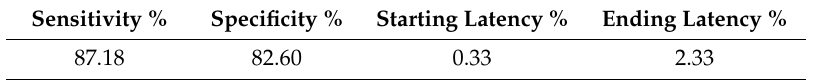
Table 2. Percentage values of sensitivity and specificity averaged over the total recording time; starting latency and ending latency averaged over all of the ON state